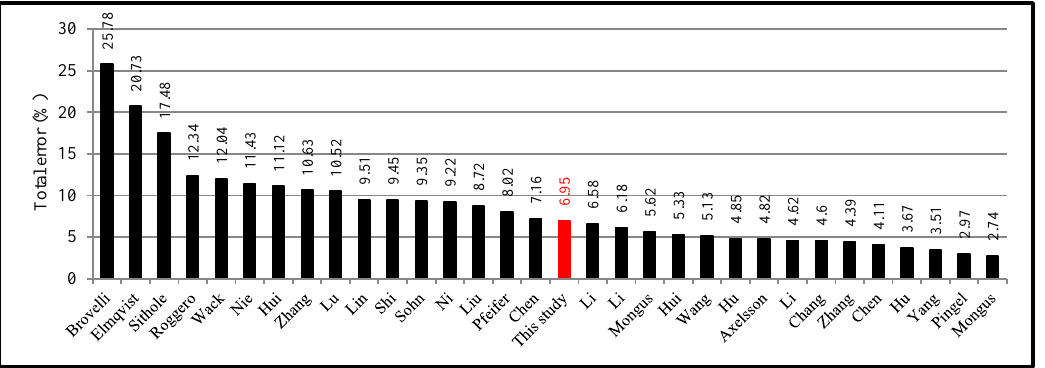
Figure 14. Total error average on 15 samples for 32 filters, in which CR value in the proposed algorithm is set to 0.5 m. The proposed algorithm is marked in red.